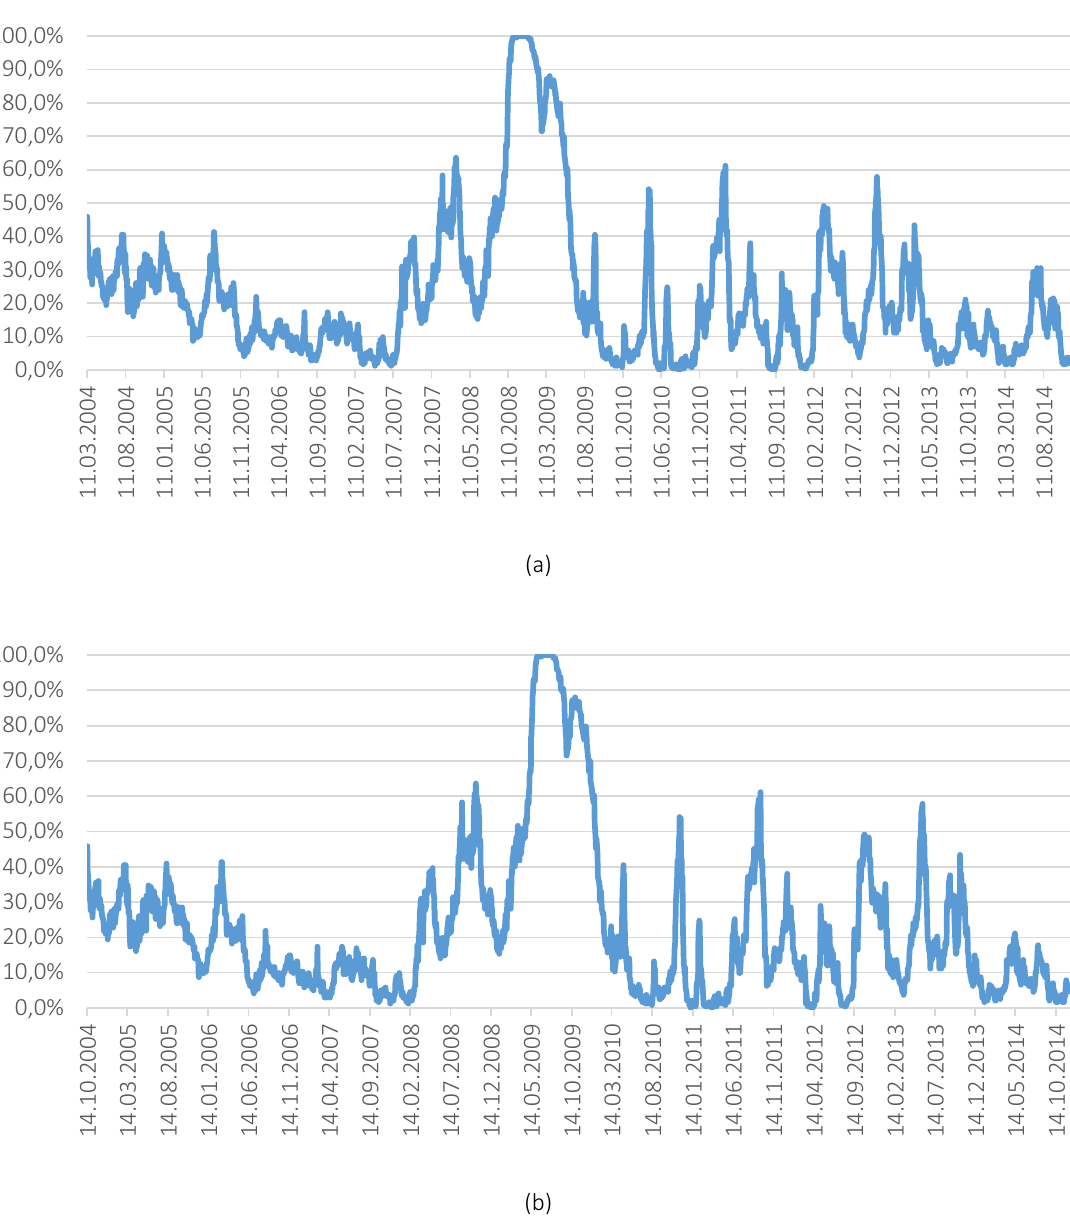
Note: Figure 6 depicts the percentage of individual stock returns, which rejected the equality hypothesis at each given date, measured as the number of stocks for which the hypothesis was rejected at every given sample, over the total number of stocks. The rolling sample size was set at 1,000 daily observations and the forecast sample at 50 and 200 for panels (a) and (b), respectively. The dates depict the end-date of each rolling sample. Figure 6. Fifty (50) and two-hundred (200) observation forecast sample using Cramér-von Mises